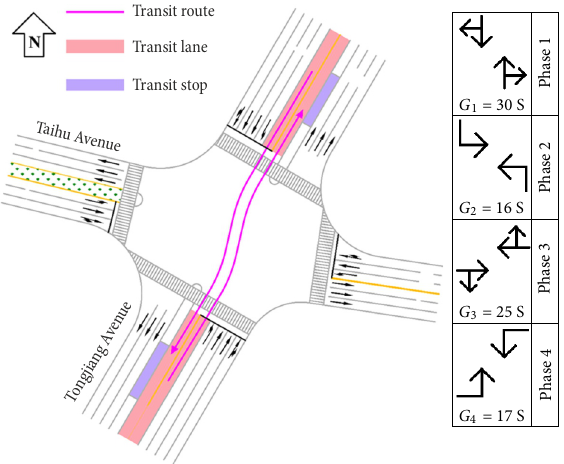
Fig. 3. Phase design and layout of the test